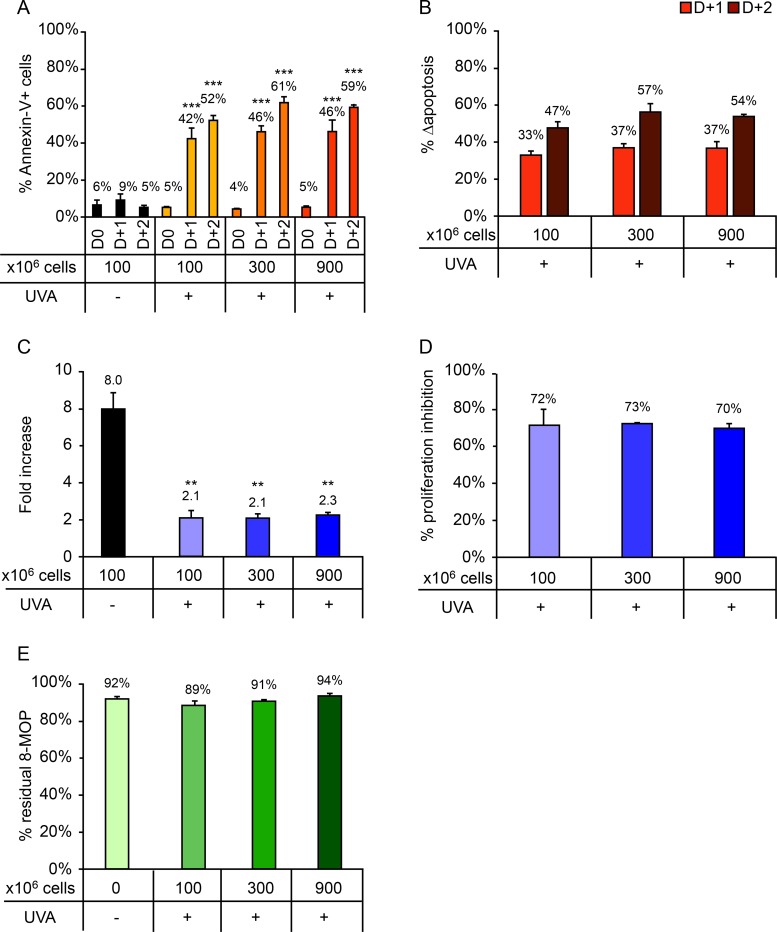
Impact of cell density (100 × 106, 300 × 106, and 900 × 106 cells) on cellular response after UVA irradiation (2 J/cm2).(A) Percentage of Annexin-V+ cells measured daily up to 2 days after irradiation. (B) Δapoptosis determined on days 1 and 2 post-irradiation. (C) Fold increase on day 3 post-irradiation relative to day 0. (D) Proliferation inhibition percentage, calculated as the percentage decrease in proliferation in irradiated versus control samples. (E) Residual 8-MOP remaining in the irradiation container after treatment, expressed as a percentage of the pre-irradiation 8-MOP concentration. For clarity, only statistically significant results are shown. *p<0.05; **p<0.01; ***p<0.001. Significant differences with respect to the control (UVA -) are indicated with an asterisk above the relevant bar, while comparisons between irradiated samples are indicated with an asterisk over a line linking the relevant bars. For Annexin-V+ cells (A) and Δapoptosis (B), comparisons performed on days 1 and 2 post-irradiation are indicated in black and gray, respectively.